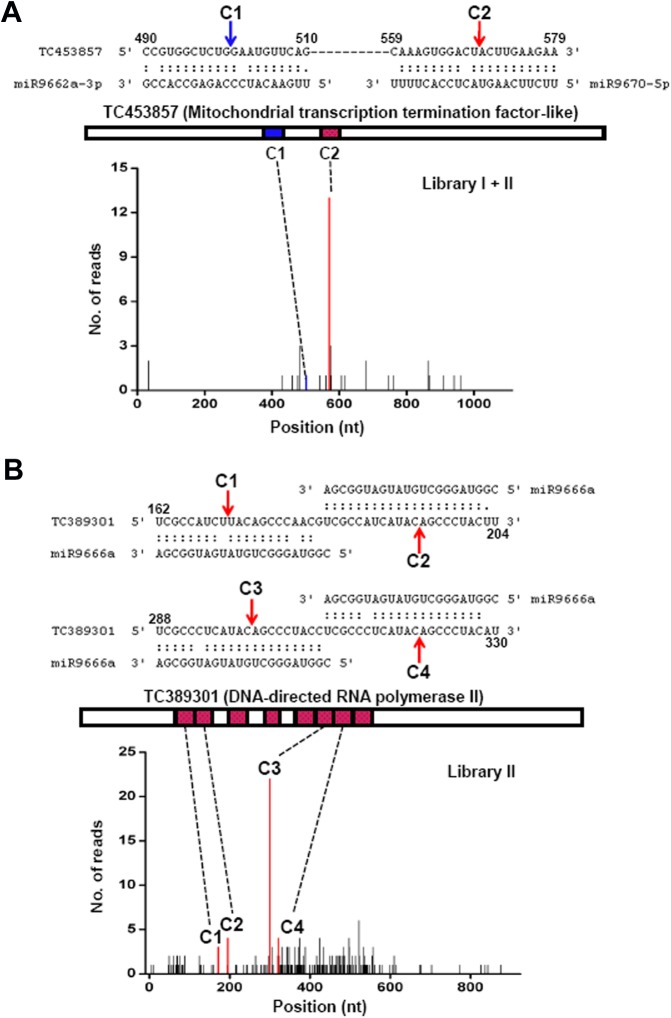
Identification of two unique targets for non-conserved development-related miRNAs.(A) A target (TC453857) was regulated by two different miRNAs. The predicted cleavage sites (C1 and C2) were shown in the blue and red boxes in the transcript, respectively. The blue or red lines in the t-plot indicate sequence abundances consistent with the C1 site or C2 site. miRNA:mRNA alignments along with C1 and C2 sites are shown above. (B) A target (TC389301) with multiple similar miRNA sites was intensively regulated by miR9666. The predicted cleavage sites are shown as red boxes in the transcript. The red lines in the t-plot indicate sequence abundances consistent with the C1–C4 sites. miRNA:mRNA alignments along with C1–C4 sites are shown above. Degradome data origins are indicated in the t-plots.